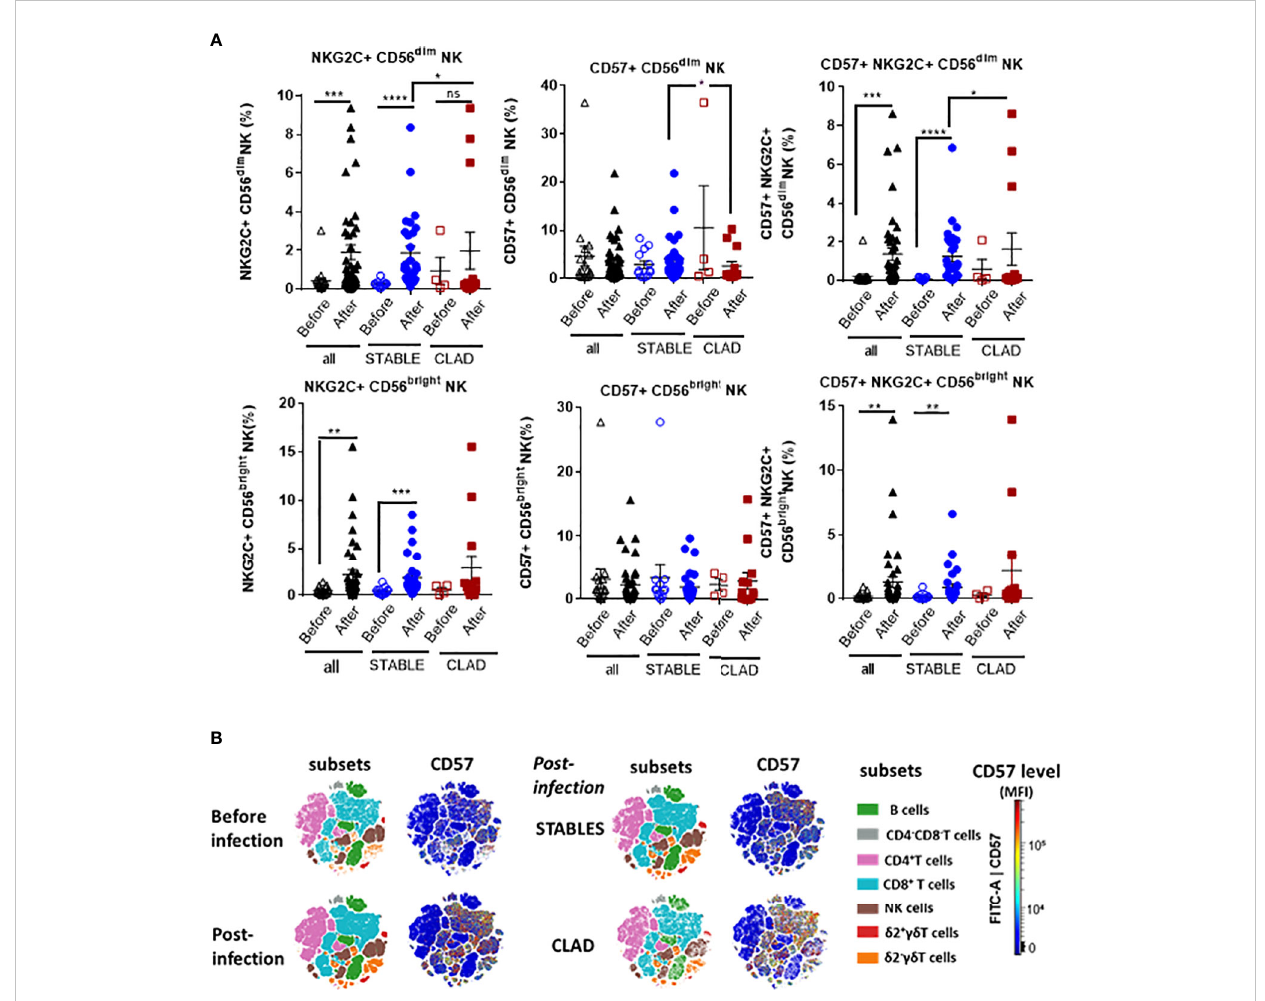
FIGURE 6 Relative distribution of adaptive/memory NK cell subsets and CD57 level post-HCMV infection in CLAD versus STABLE LTRs. (A) Spectral fl ow cytometry data were analyzed to identify NK cell subsets using manual gating. The two main populations of CD3 − CD16 + CD56 dim and CD3 − CD16 + CD56 bright NK cells were fi rst segregated and further investigated for the expression and co-expression of the CD57 and NKG2C markers. This analysis included samples harvested before (open labels) and after (closed labels) HCMV infection for all LTRs ( n = 17 samples before and n = 40 samples after the infection, black labels), STABLE LTRs ( n = 13 samples before and n = 28 samples after the infection, blue labels), and CLAD LTRs ( n = 4 samples before and n = 12 samples after the infection, red labels). Results are shown as box blots with median and interquartile values; each point represents a single sample. The groups were compared using the Mann – Whitney U test; p -values: * for p < 0.05, ** for p < 0.01, *** for p < 0.005, and **** for p < 0.001. (B) Visualization (opt-SNE) of the relative abundance of the seven main lymphocyte populations on samples and overall CD57 expression level from all LTRs (STABLE and CLAD samples embedded) harvested before ( n = 17) and after ( n = 40) HCMV infection (left panel) and (right panel) in samples harvested after HCMV infection from either the STABLE ( n = 28 samples from 13 LTRs) or CLAD ( n = 12 samples from 5 LTRs) LTRs (left panel). Lymphocyte populations including B, NK, CD4 − CD8 − T, CD4 + T, CD8 + ab T, d 2 − gd T, and d 2 + gd T cells were identi fi ed using manual assignation based on phenotype markers (Figure